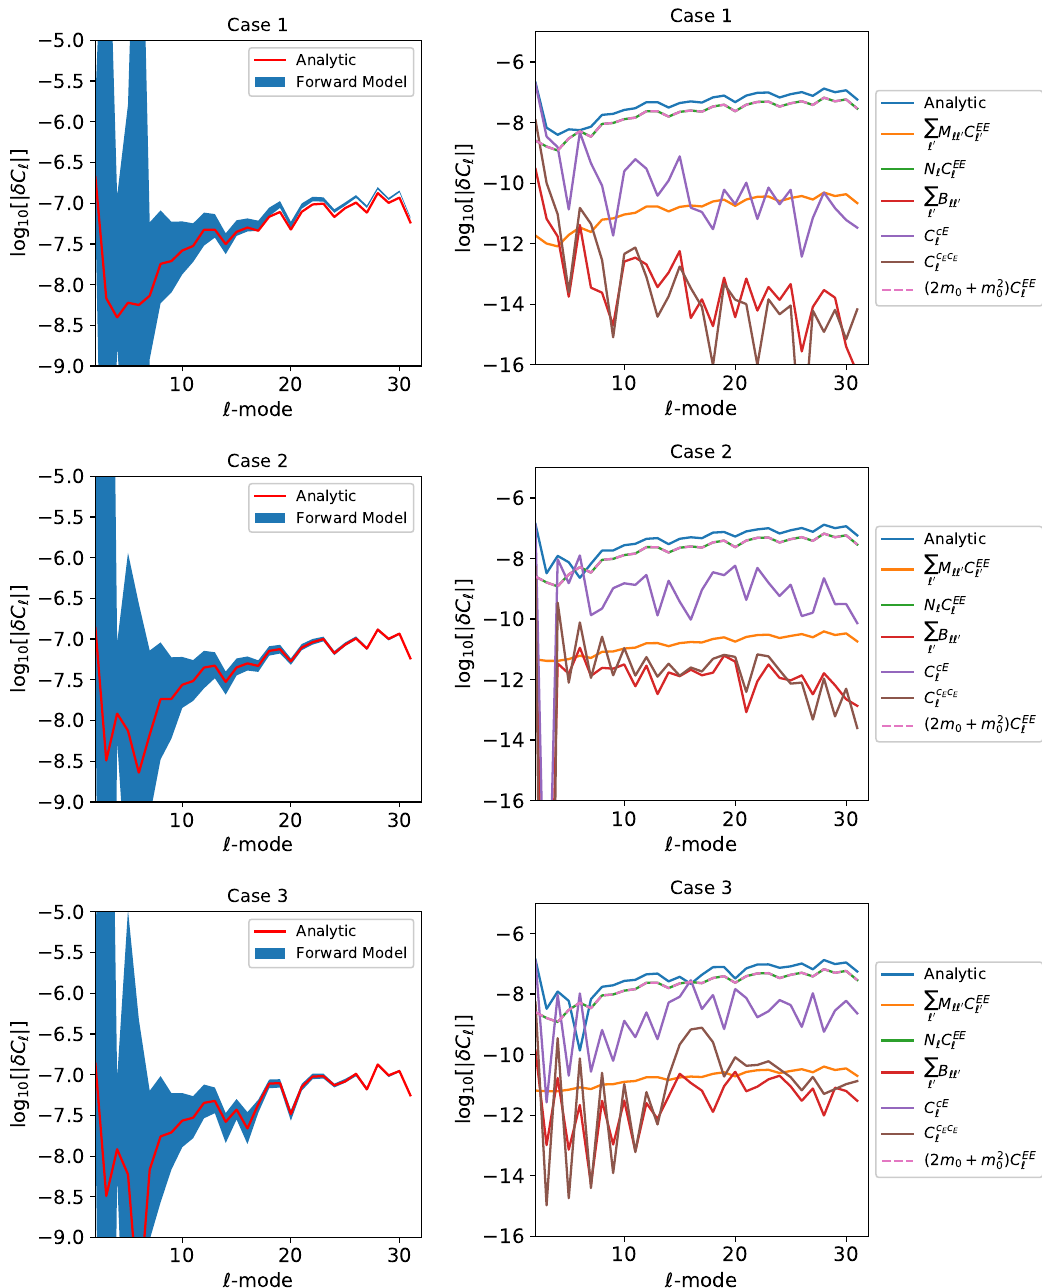
Fig. 2.— The residual power spectrum δ C ℓ = C EE ℓ − C EE ℓ for the three cases considered. The left plots show the comparison between the numerical case computed by transforming the modified shear field and performing a spherical harmonic transform (i.e. a forward model), and the analytic case computed using equation (7). The blue band shows the 1 -sigma scatter about the mean of forward model, the red e lines show the analytic prediction. The right plots show the contribution to the analytic case from each of the components in equation (7). In all cases the legends label the coloured lines. The mean multiplicative terms (green and pink lines) have the same value due to the scaling, and hence are